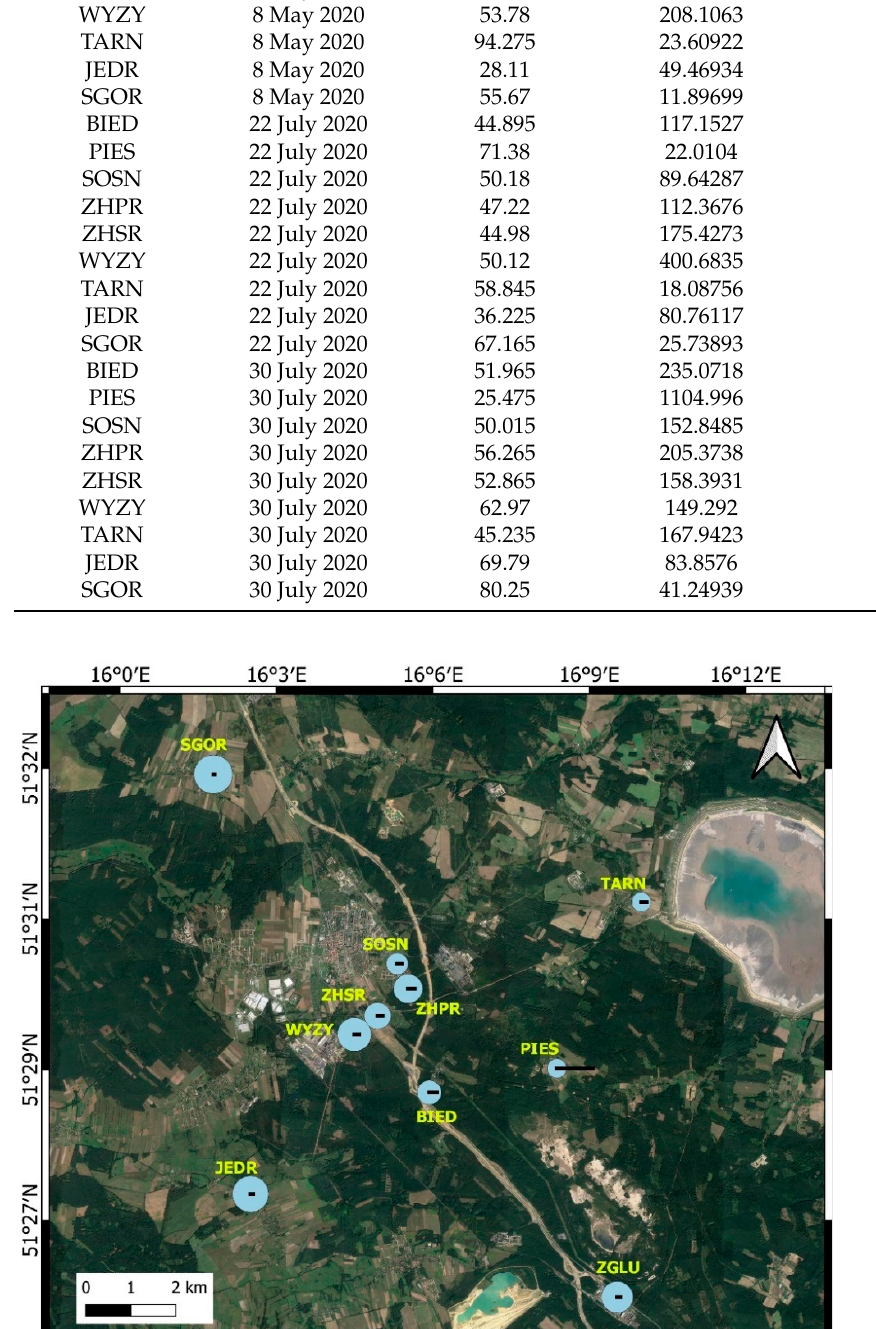
Figure 9. Locations of the seismometers in the AOI. The area of the blue circles is proportional to the maximum acceleration of the seismic event recorded on 30 July 2020, the length of the black bar is proportional to its temporal duration. Table 4. Summary of the main seismic events recorded by the seismometer stations. Station